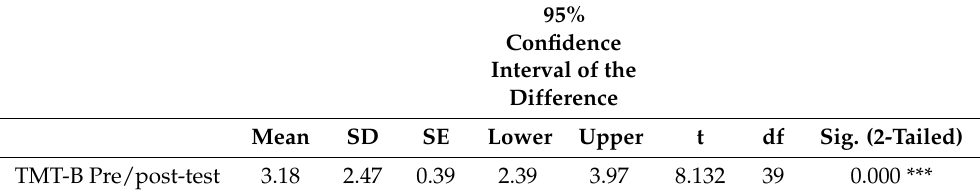
TMT-B Pre/post-test